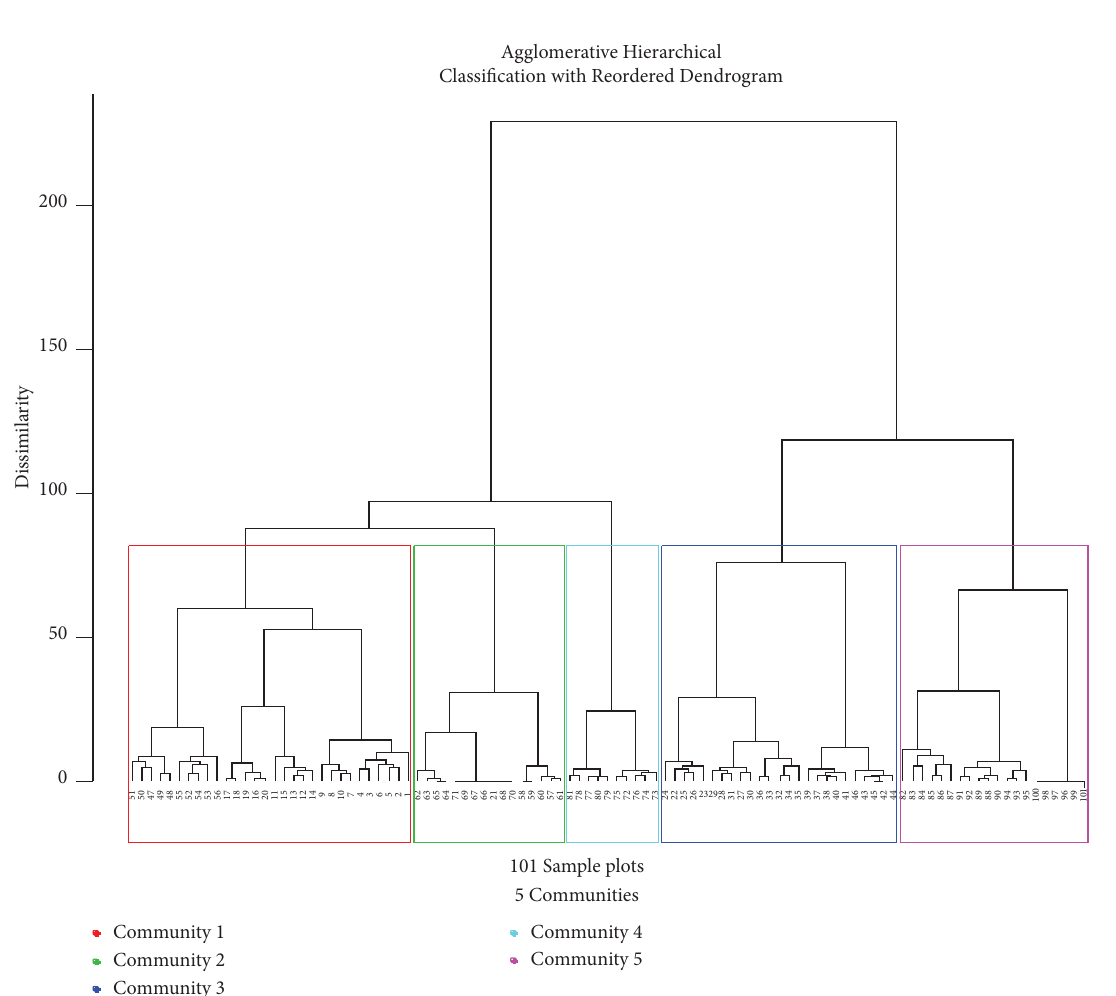
Figure 6: Dendrogram showing plant communities in the study